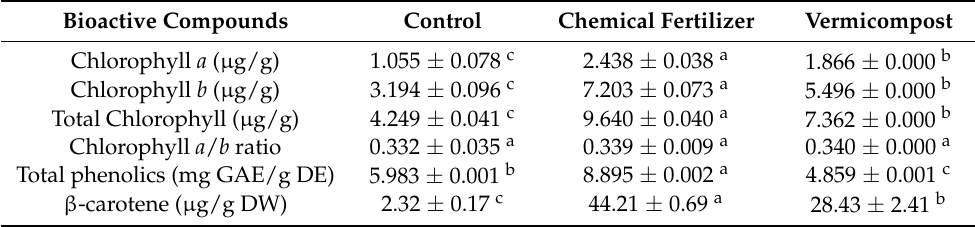
Table 2. Pigments content, total phenolics content (TPC), and β -carotene content of MD2 pineapple fruit extract grown with different types of